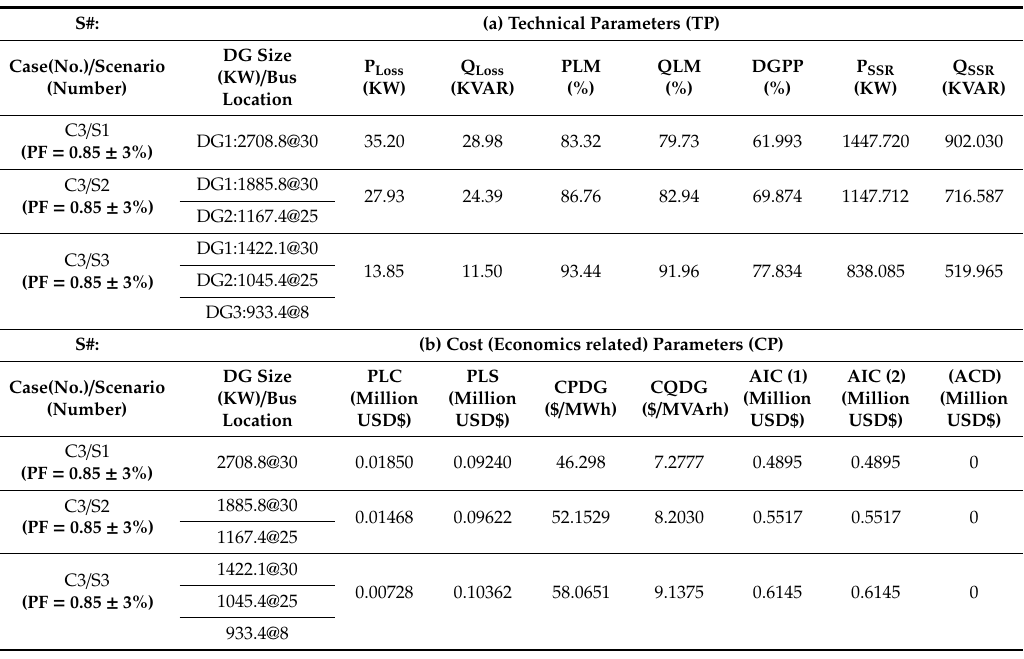
Table 7. (a) Overview of technical performance evaluation analysis in case 3 (33-bus). (b) Overview of Cost-economics performance evaluation analysis in case 3